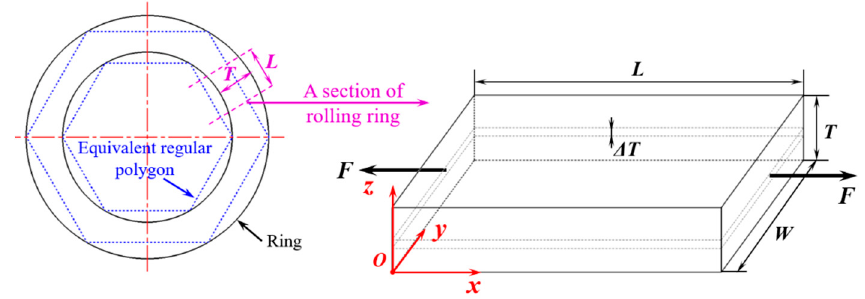
Figure 4. Simplified equivalent model of rolling ring.